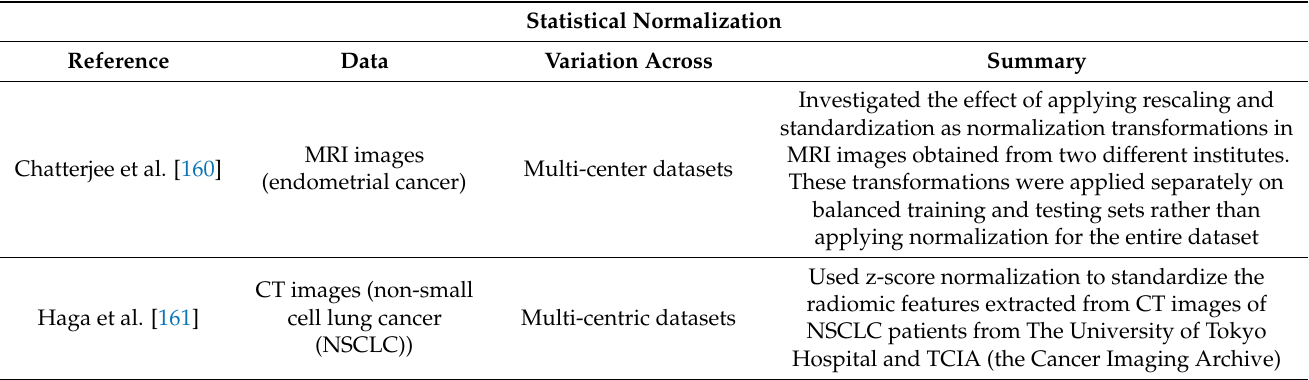
Table 6. Summary table of basic statistical approaches.